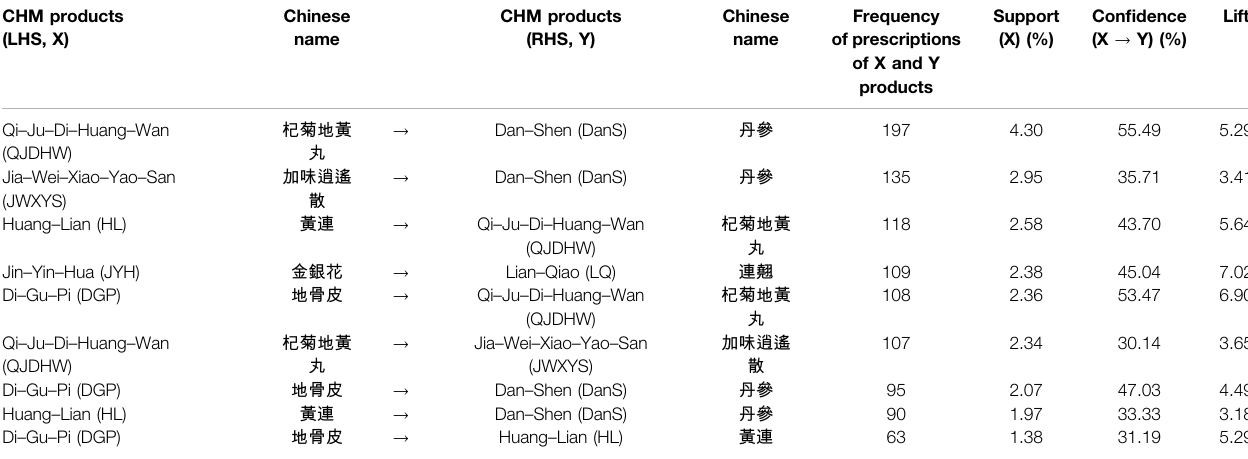
TABLE 3 | Most commonly used two CHM combinations for patients with pemphigus in Taiwan. CHM products (LHS,